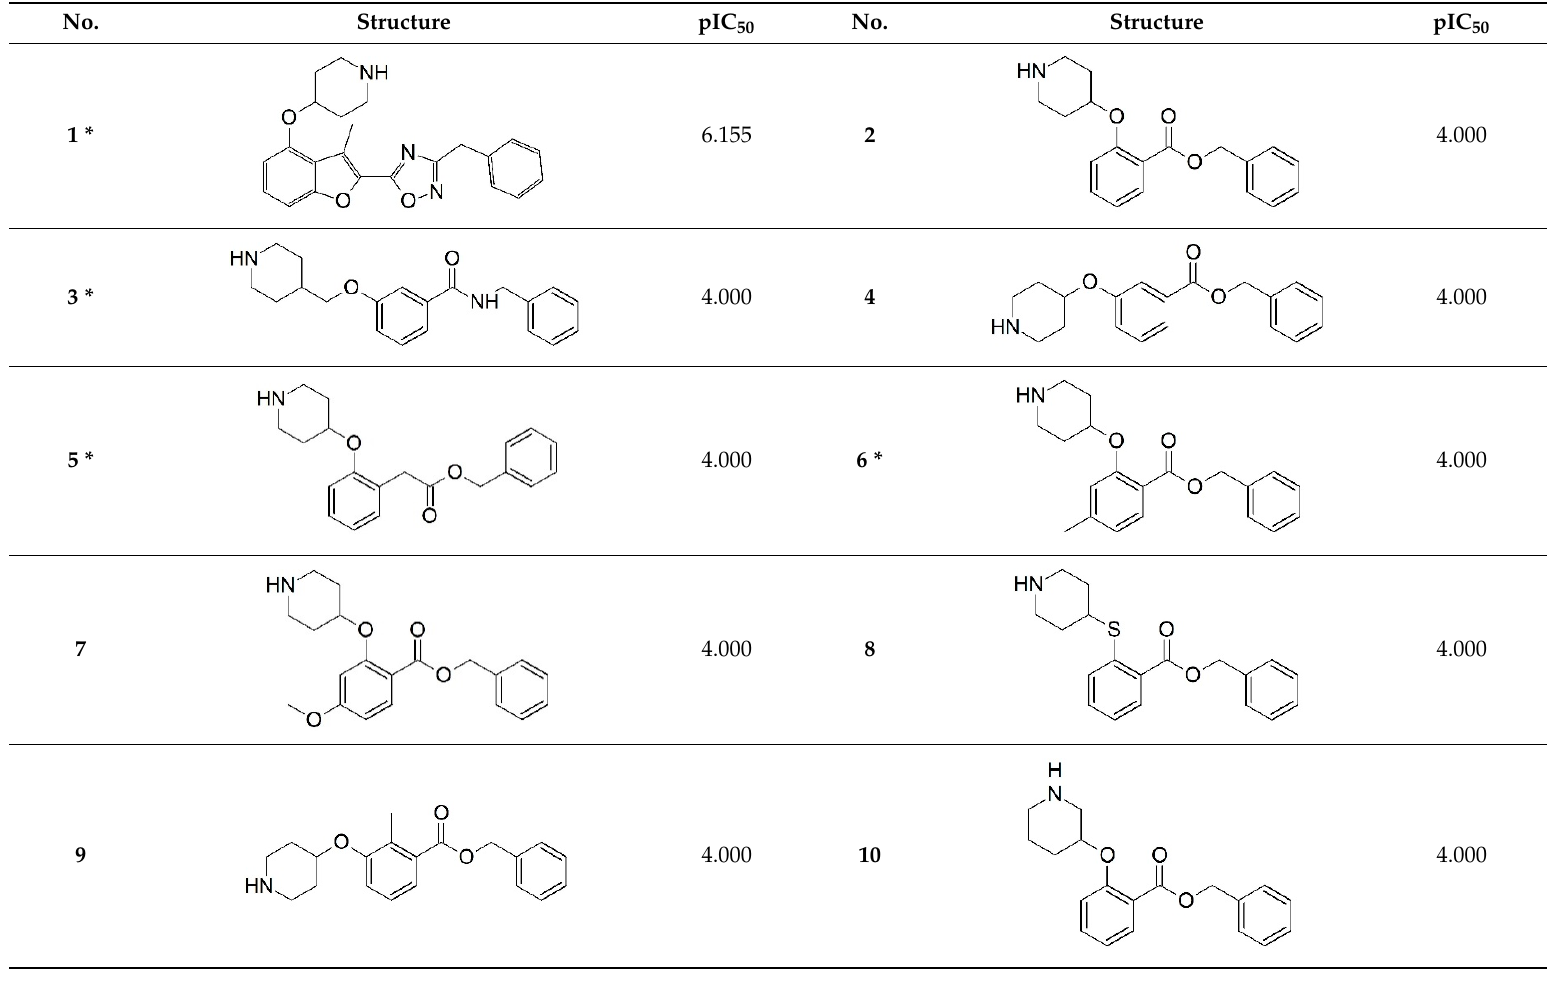
Table 5. Chemical structures and experimental pIC 50Exp (M) values of Plasmodium falciparum inhibitors. Test Set I compound numbers are marked with an asterisk. Test Set II compound numbers are underlined.